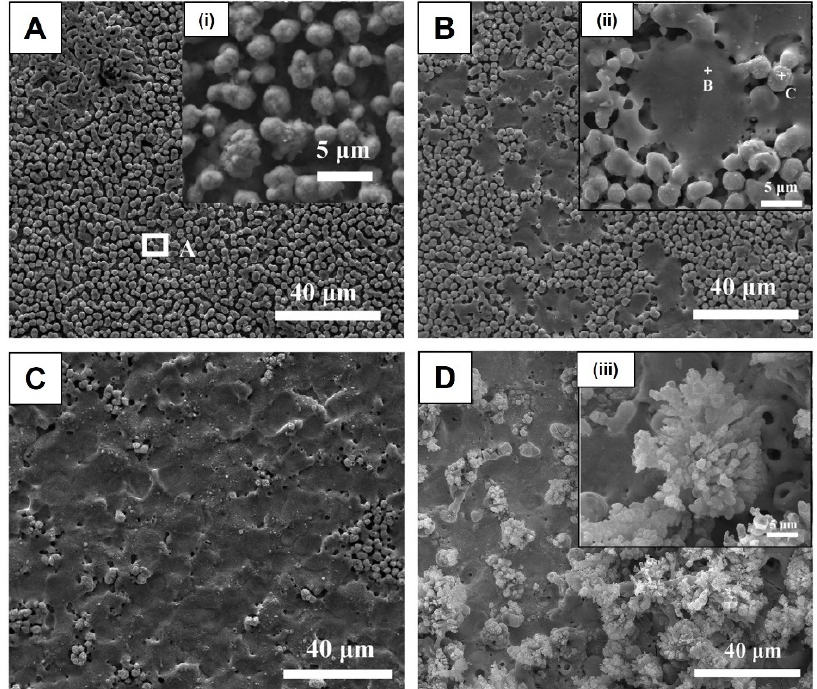
Figure 16. Surface morphologies of MAO-treated Ta surface using a silicate electrolyte in a bipolar pulsed current for ( A ) 120 s, ( B ) 140 s, ( C ) 180 s, and ( D ) 600 s (scale bar: 40 μ m). Inset high magnification SEM micrographs of the ( i ) A , ( ii ) B and ( iii ) D morphologies (scale bar: 5 μ m). Adapted with permission from Ref. [63]. Copyright 2020 Elsevier.